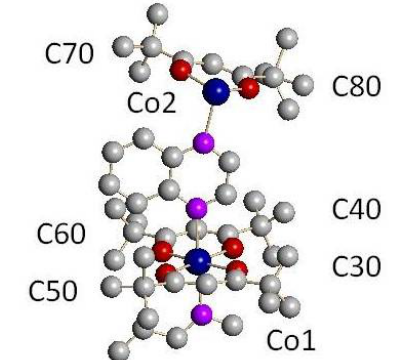
Figure 5. Ball-and-stick model showing a portion of the wavelike polymer chain of trans -[Co(tmhd) (qox)] ( 3 ). The hydrogen atoms are not included for clarity (C, gray; 2 n Co, blue; N, purple; O, red).